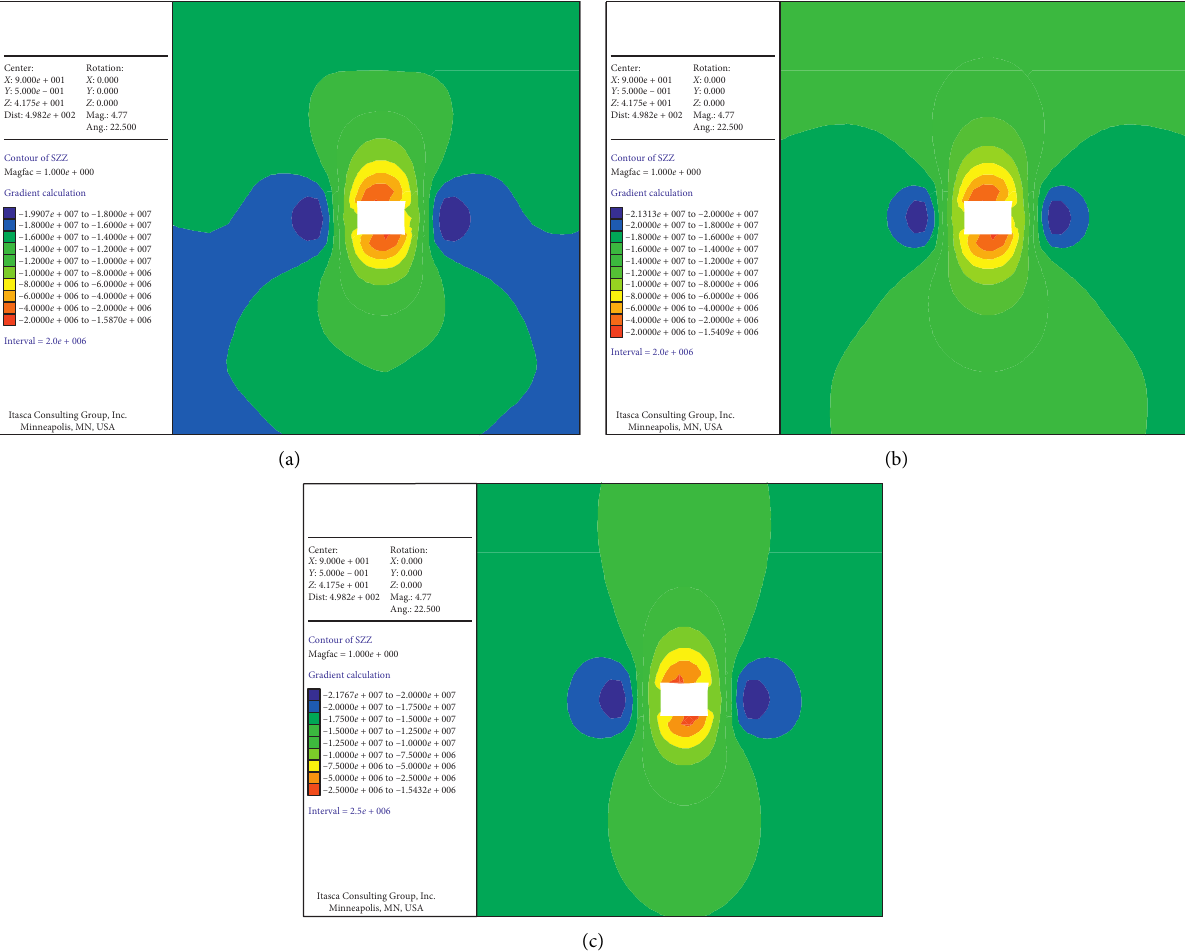
Figure 8: Cloud diagram of vertical stress. (a) 300 step; (b) 600 step; and (c) 2100